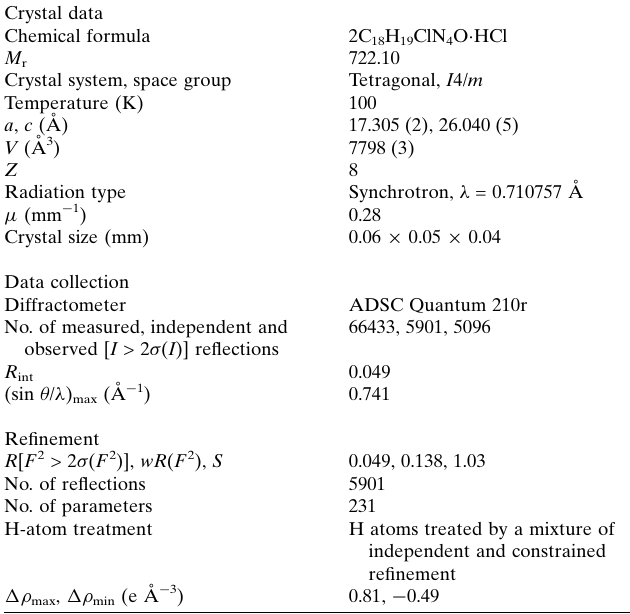
Table 3 Experimental details. Crystal data Chemical